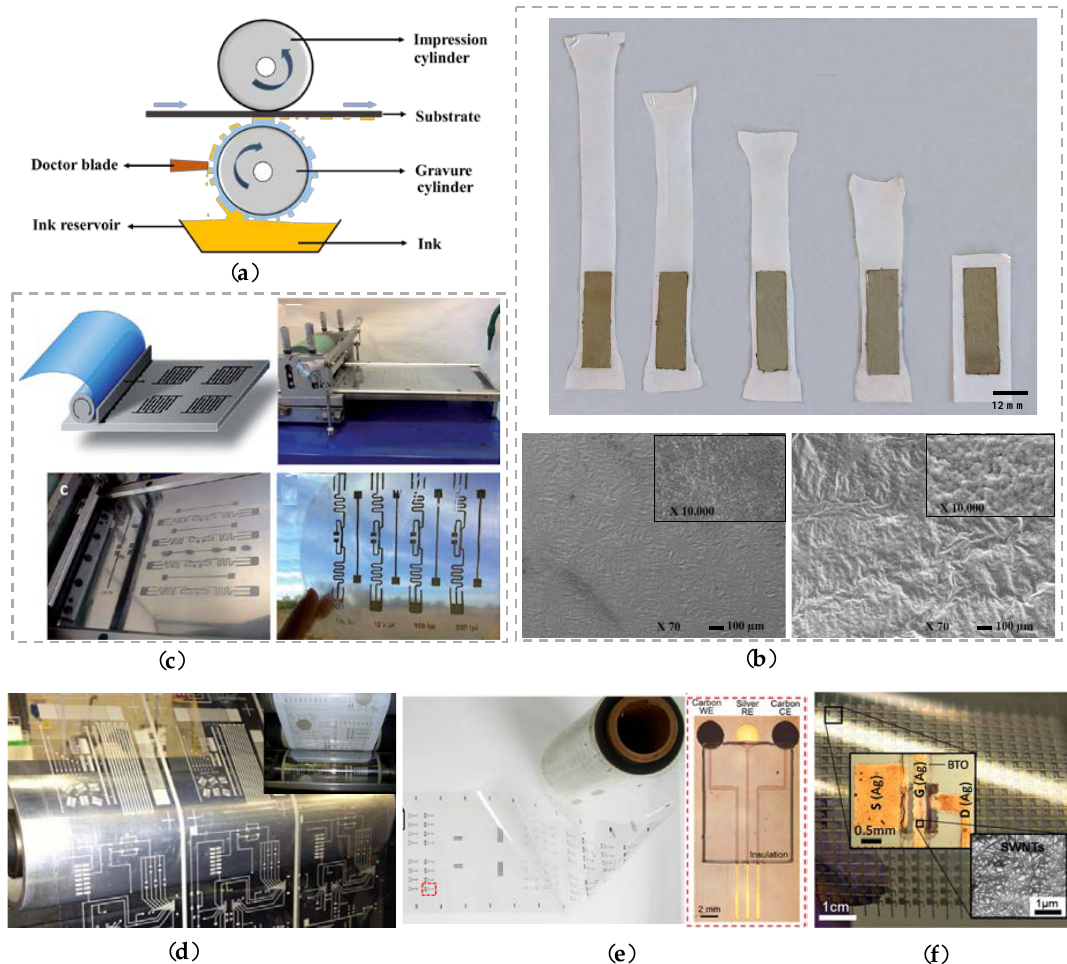
Figure 4. ( a ) Schematic of gravure printing process; ( b ) wrinkle-structure-based SERS substrate with SEM micrographs showing the plain and wrinkle structures on stretchable thermoplastic polyurethane (TPU) substrate, Reprinted from [131] with permission from Elsevier; ( c ) stable transparent nanopaper-based RFID antenna [132], Republished with Permission of RSC Pub; ( d ) R2R manufacturing of large area printed circuits and antenna structures; ( e ) electrochemical sensors on a PET roll for detecting ions, metabolites, heavy metals, and other small molecules, Reprinted with permission from [136], © American Chemical Society; ( f ) fully printed CNT-based high performance TFT arrays, Reprinted with permission from [137], © American Chemical Society.